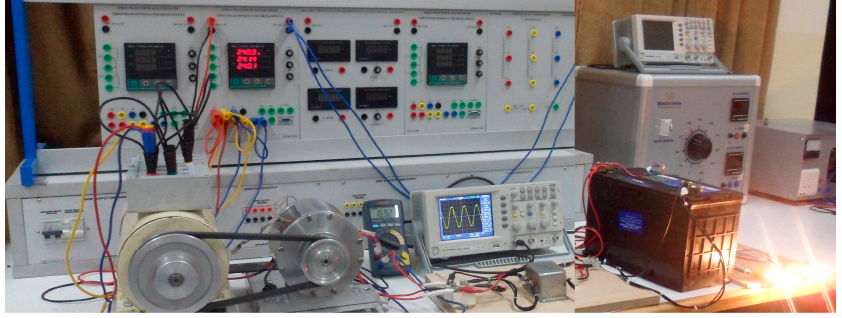
Figure 26. Testing of AFPMA and AC/DC converter under charging process (battery and load connected).